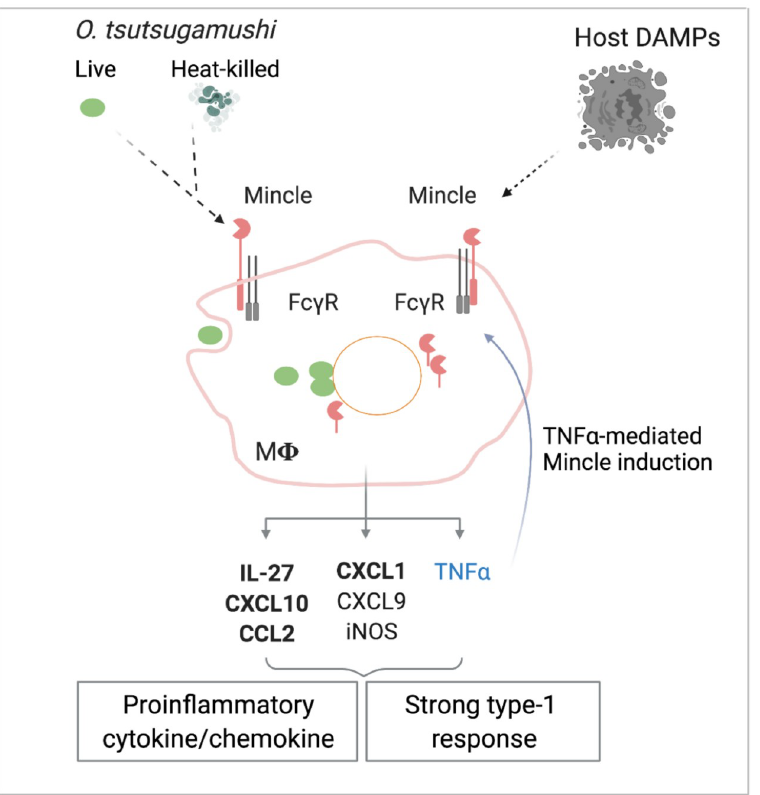
Fig 10. A schematical model for the role of Mincle/Fc γ R in M F responses to O . tsutsugamushi . O . tsutsugamushi bacteria and yet-undefined bacterial components, as well as damaged host molecules (DAMPs) can selectively stimulate Mincle/Fc γ R expression in M F , leading to subsequent production of proinflammatory cytokines/ chemokines in inflamed tissues. While such immune responses help the control of bacterial replication, sustained Mincle-related responses also activate Mincle-dependent proinflammatory factors, including IL-27, CXCL10, CXCL1, and CCL2 (in bold). Meanwhile, Mincle-independent host factors (e.g., TNF α ) can further promote the magnitude of Mincle expression via a positive regulation loop. Collectively, these events promote type 1-skewing immune responses, cellular damage, and acute lung injury.